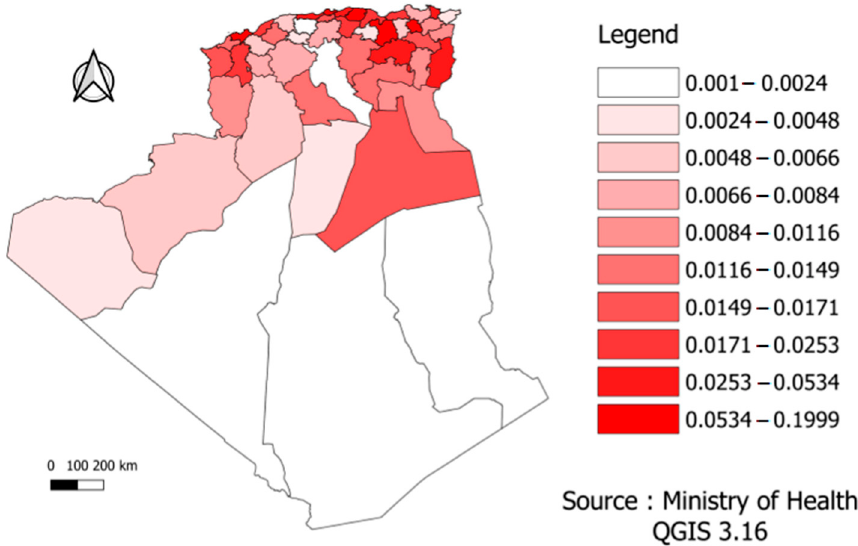
Figure 11. Risk distribution of COVID-19 infection by province.